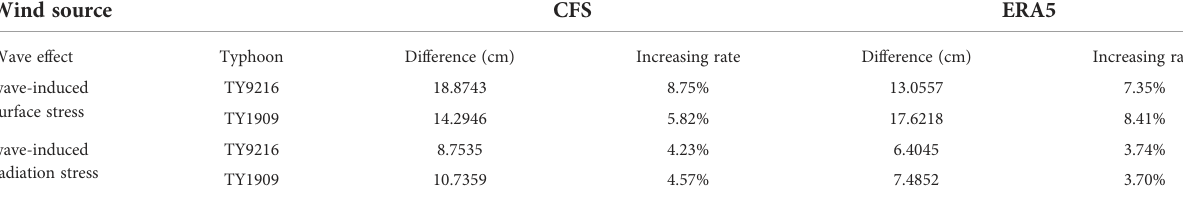
TABLE 6 The difference in the average inundation depth along the LZB during TY9216 and